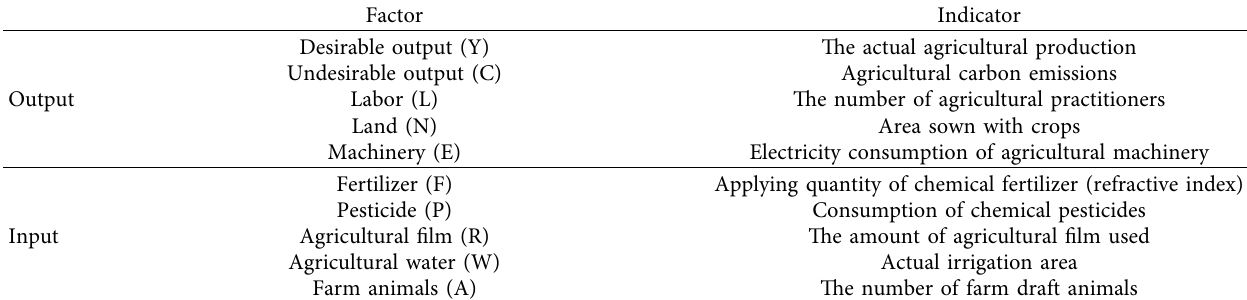
Table 1: Construction of input and output indicators.